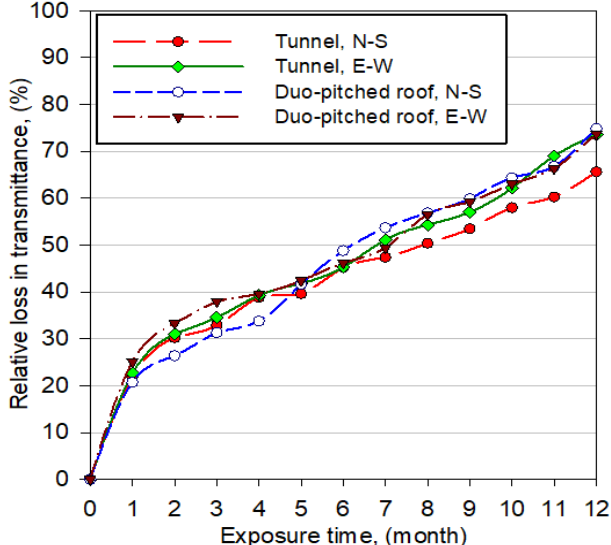
Figure 8. Relative losses in the cover transmittance estimated for the two greenhouse prototypes, oriented in the N–S and E–W directions and exposed for one year to the arid climatic agents.